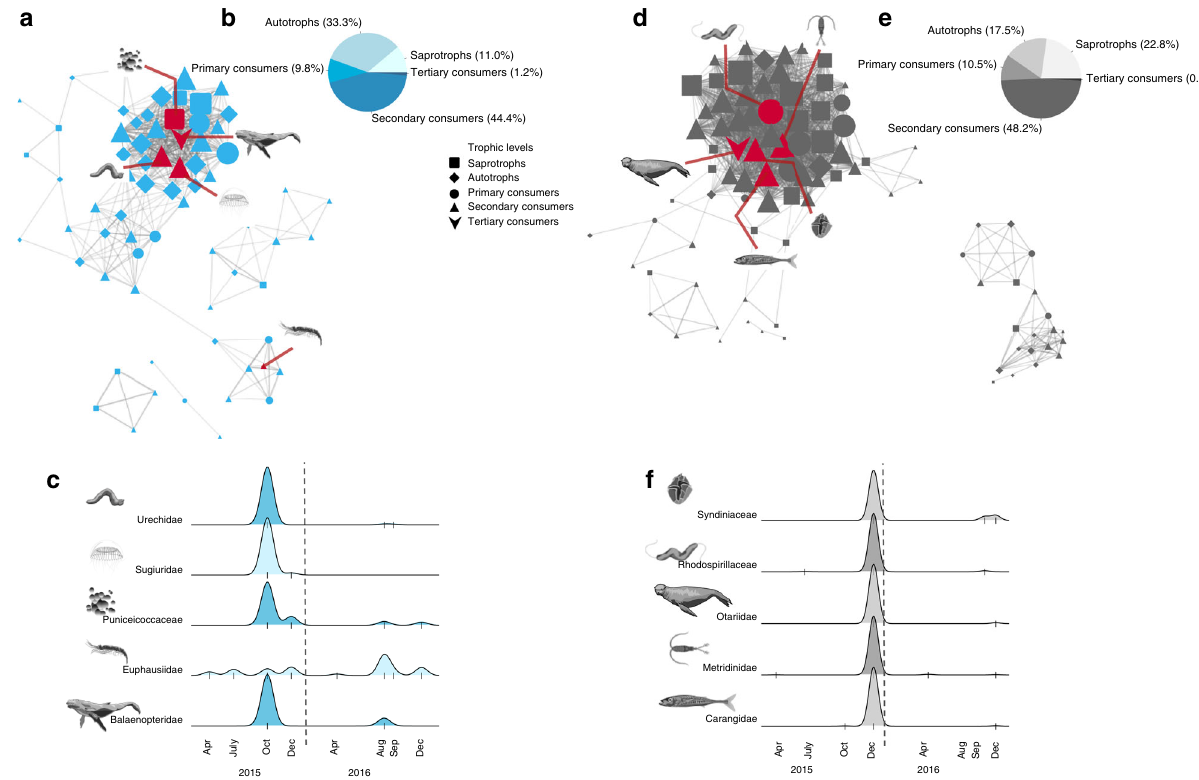
Fig. 2 Network visualisation and amplicon-index abundance of selected taxa over time. Network visualisation for the autumn 2015 and 2016 (blue) subnetwork ( a – c ) and the December 2015 (grey) subnetwork ( d – f ). The blue ( a ) and grey ( d ) subnetworks are visualised with nodes (taxa) and edges (correlations) representing the connections between the individual taxa. To best visualise the subnetworks, only taxa with a network connection (edge weight) above a threshold of 0.2 are shown (i.e., low correlations were removed, see Methods for edge calculations). The different trophic levels detected within the subnetworks are represented by different symbols, see legend. These panels illustrate the complexity of the co-occurring taxa in the blue and grey subnetworks, upon which the taxa representations of panels ( c ) and ( f ) are chosen. The distribution of the trophic levels within each subnetwork is represented in ( b ) and ( e ). The size of the taxon node symbol is relative to the number of edge connections that an individual taxon has within the subnetwork and the width of the edges represents the weight of the correlation between two given nodes. The red lines within each subnetwork point to highly correlated taxa ( r > 0.9) or highly connected taxa (within the top 10%) within the subnetworks, highlighted in ( c ) and ( f ). The scaled abundances of these taxa are presented in ( c ) and ( f ) during the course of our sampling period. The tick marks in the x -axis of plots ( c ) and ( f ) represent the times of sampling when we have observations of these taxa, the height of the y -axis is relative to the number of observations per taxon and does not represent absolute abundance values or biomass. The vertical dashed lines represent January 1,